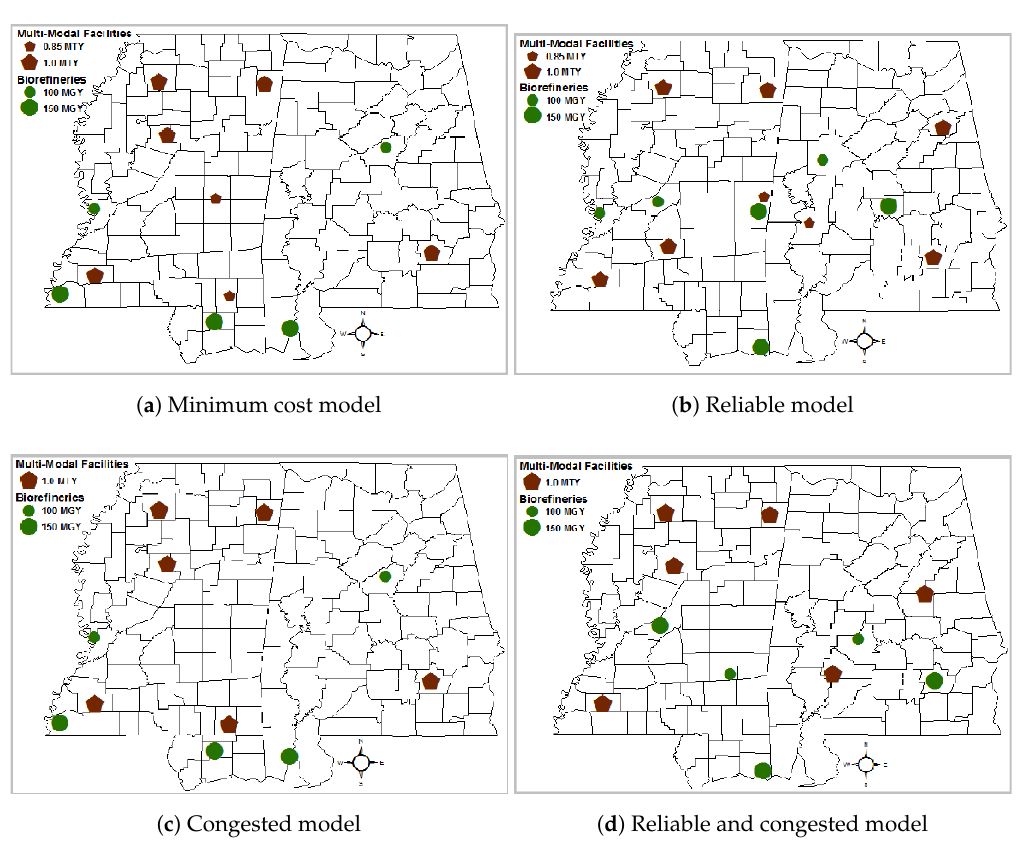
Figure 10. Network representation of minimum cost, reliable, congested, and reliable and congested